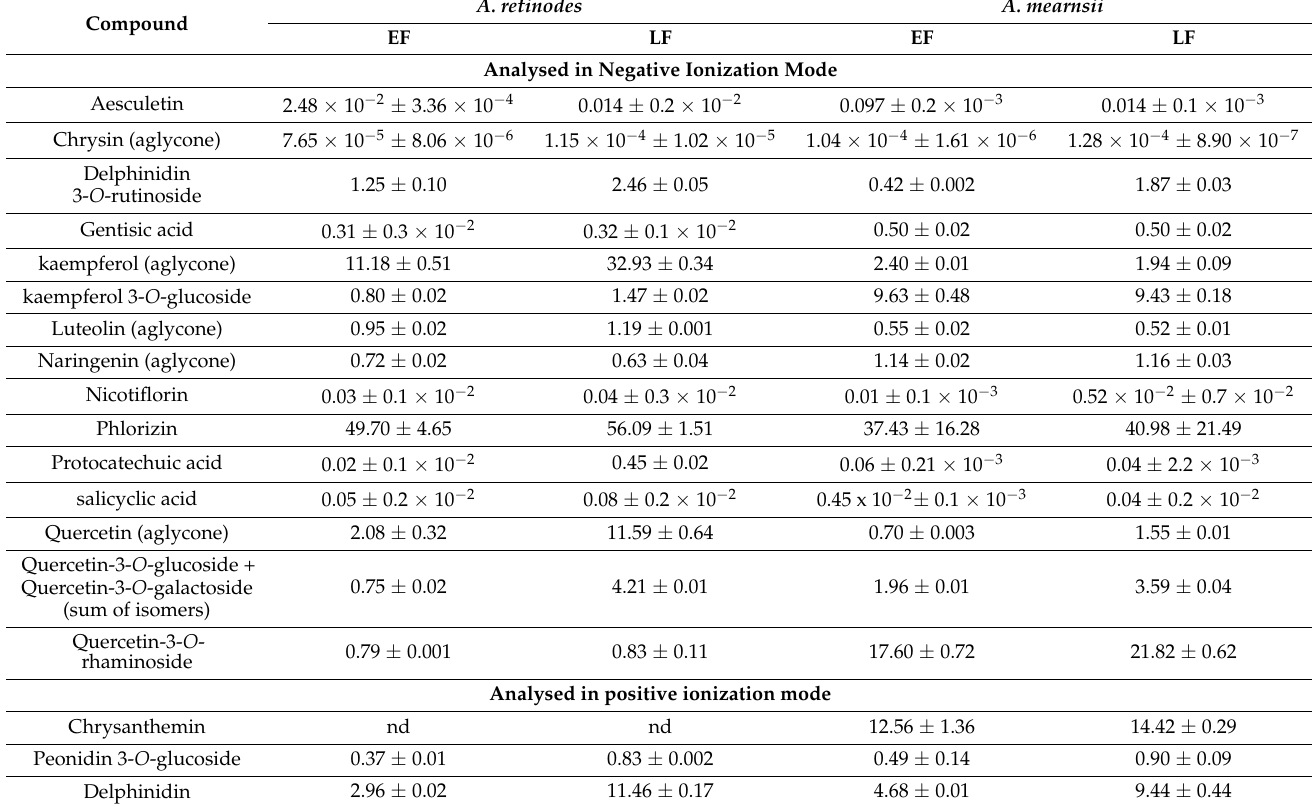
Table 5. Estimated concentration of phenolic compounds ( µ g/g) in the ethanol extracts from A. retinodes and A. mearnsii flowers by UHPLC/ESI-QTOF-MS (mean ± standard